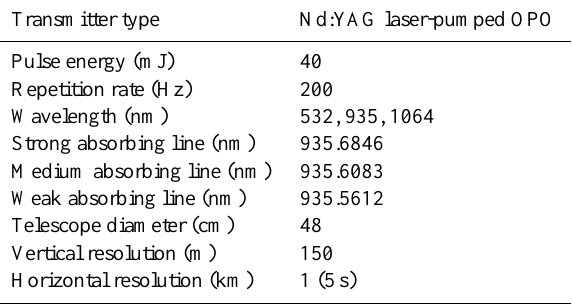
Table 2. System parameters of WALES.